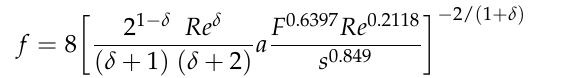
in which X = F 0.6397 Re 0.2118 s −0.849 and the coefficient a varies with biochar content and is equal to 0.0276 when BC = 0. For each dataset ( BC = 6 and 12 kg m −2 ), the behavior of the pairs ( X , Г v ) was investi- gated and the value of the a coefficient, equal to the slope coefficient of the best-fit straight line passing through the origin of the axes, was estimated. For BC = 6 and 12 kg m −2 , Figure 3 shows the comparison between the experimental pairs ( X , Г v ) and Equation (10) with a = 0.0297 for BC = 6 kg m −2 (Figure 3a) and a = 0.0311 for BC = 12 kg m −2 (Figure 3b). For the highest BC value and the lowest X values (14.4 < X < 17.4), Equation (10) with a =0.0311 tends to overestimate Г and, as a consequence, to underestimate f (Figure 4).